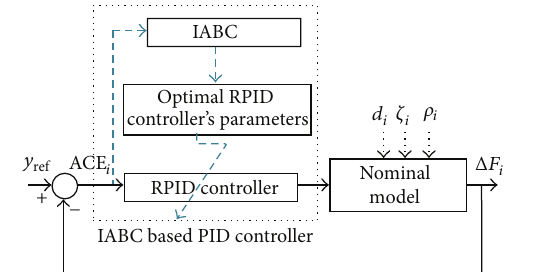
Figure 2: The introduced IABC based RPID controller structure.